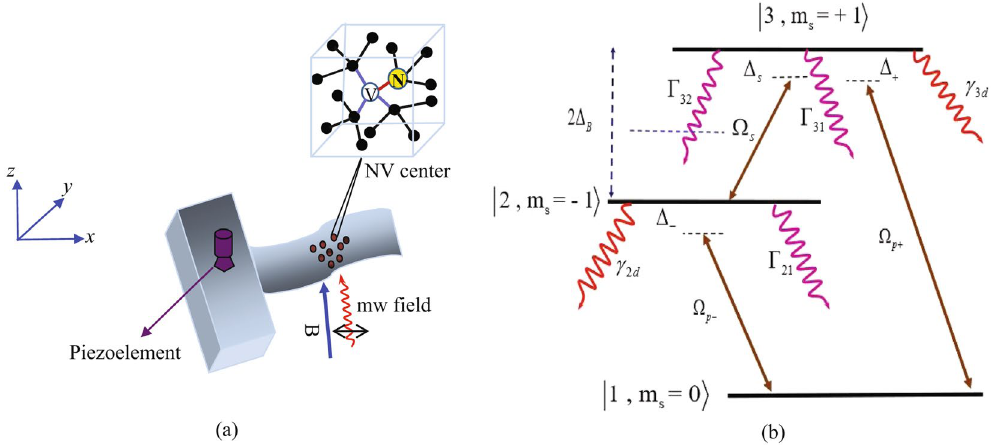
Figure 1. ( a ) The system under consideration is a DMR with many embedded NV centers. ( b ) Diagram of the three-level closed-loop of the NV center ground state. The transitions | 1 to | 2 and | 3 are driven by the left- and right- circularly polarized microwave probe field with Rabi frequency Ω − the electric dipole forbidden transition | 2 to | 3 is coupled by the strain field with Rabi frequency Ω